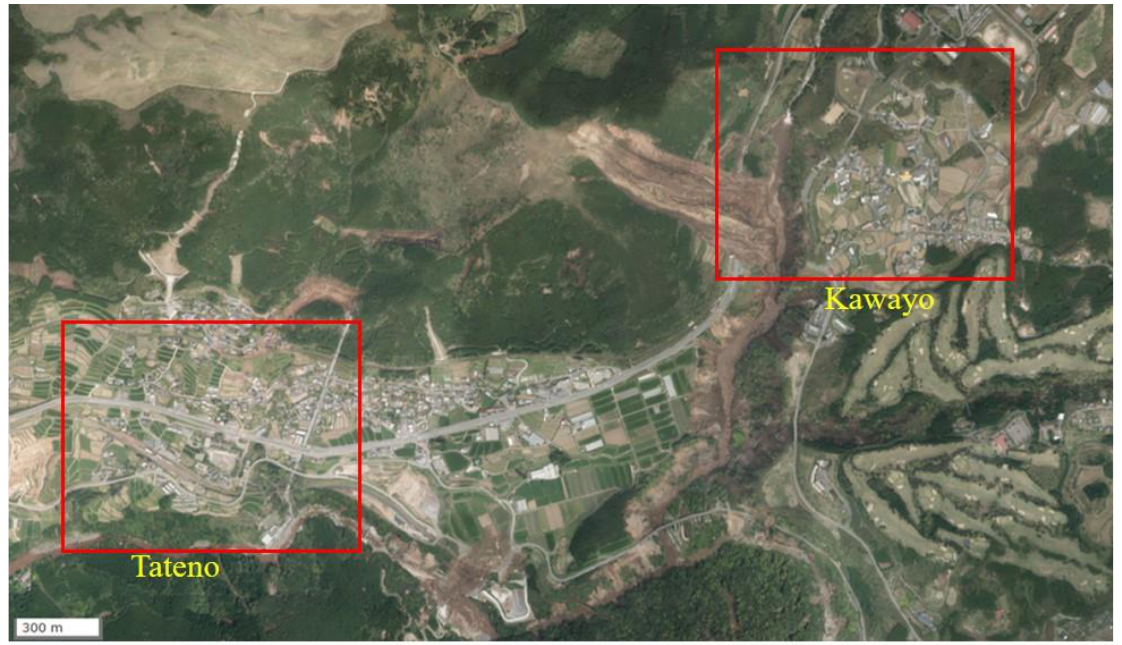
Figure 2. Orthorectified aerial photo of the study area in Minami-Aso village, including Kawayo and Tateno districts, taken by GSI on 2016/04/16